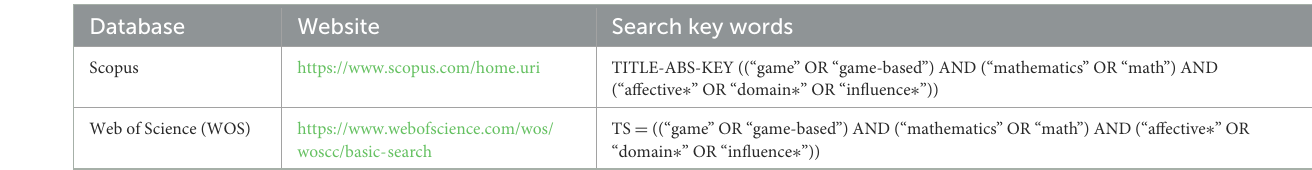
TABLE 1 Specific keywords used for the databases.